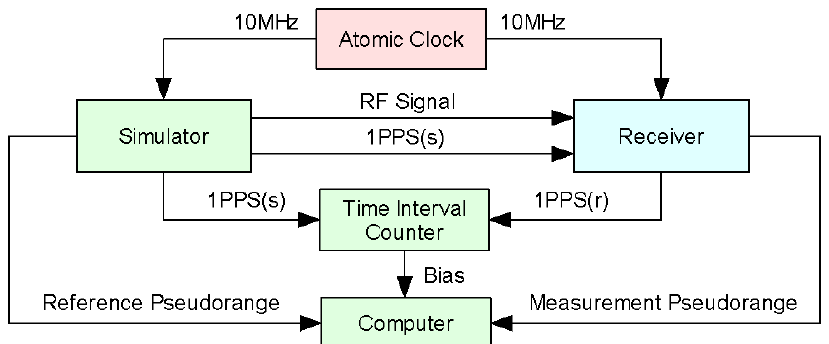
Figure 3. Principle of absolute